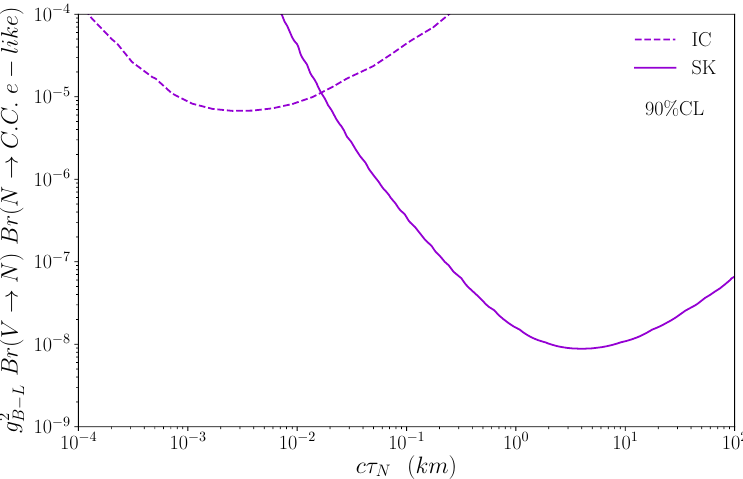
Figure 17 . Limits on dark photons decays from IceCube (thick lines) and Super-Kamiokande (thin lines) on the g 2 Br( V ! N ) vs c(cid:28) N for m V = 0 : 8 GeV and m N = 0 : 35 GeV, where B (cid:0) L Br( V ! N ) = 2Br( V ! NN